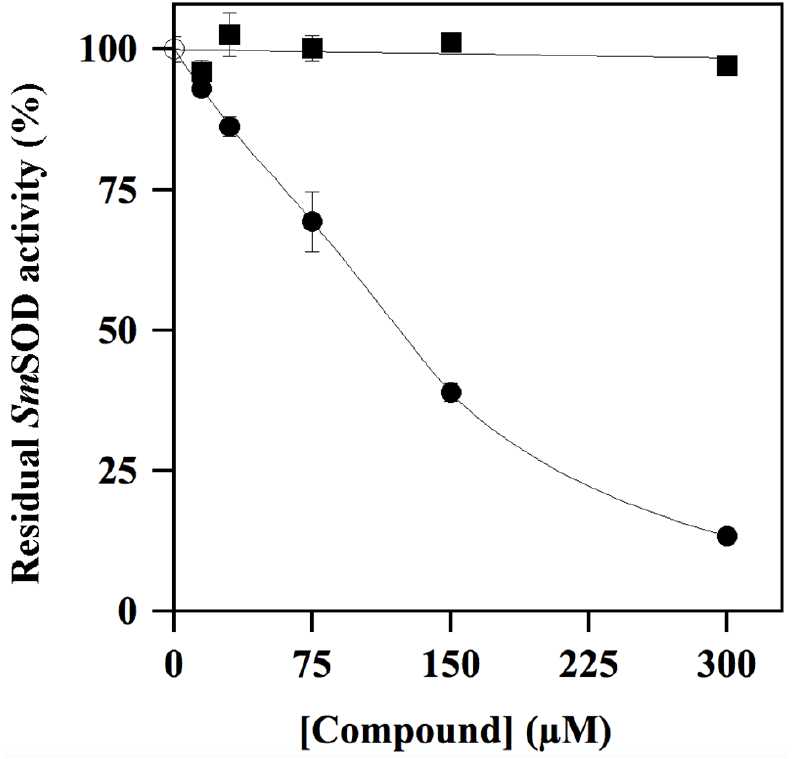
To get an insight on this effect, inhibition profiles up to 300 µ M were realised for two compounds, namely the putative inhibitor ALS-31 and an apparently ineffective molecule, such as ALS-19 . The results of a representative experiment (Figure 3) clearly indicate that only ALS-31 caused an evident dose-dependent inhibition of Sm SOD activity. The calculated value of the ALS-31 concentration, leading to 50% inhibition of Sm SOD activity (IC 50 ), was 159 19 µ M. ±